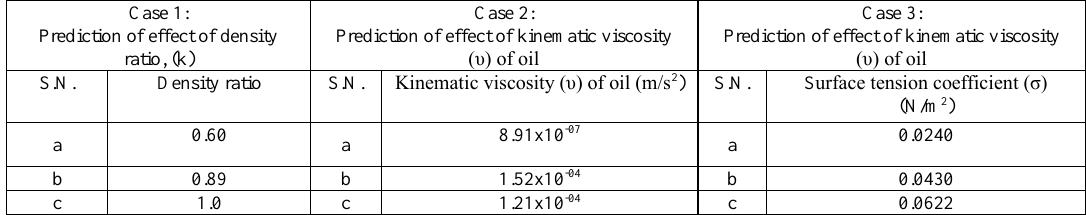
Table 1. Brief details of various cases